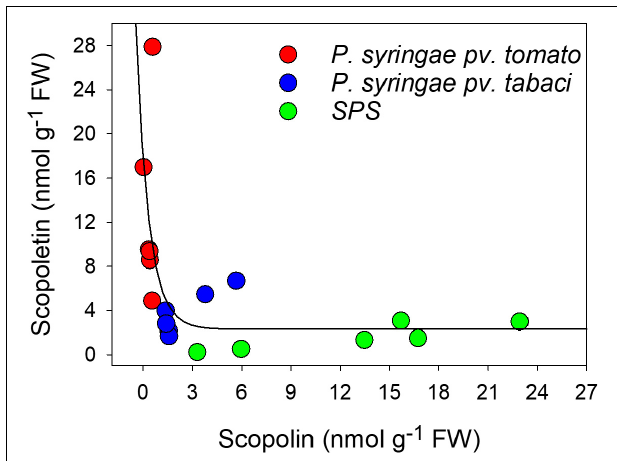
FIGURE 4 | Relationship between SCT and SCL concentrations and the infiltration treatments, evaluated by chromatographic methods. The solid line represents a curve fitting by an exponential decay